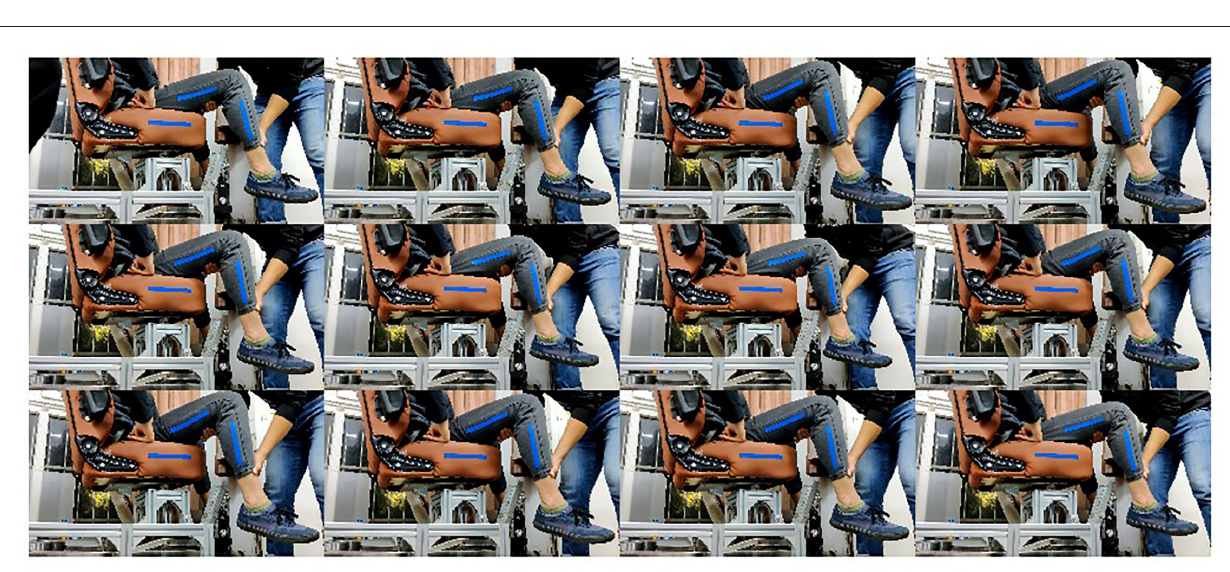
FIGURE 7 | Measurement of the hip joint range of motion in the coronal